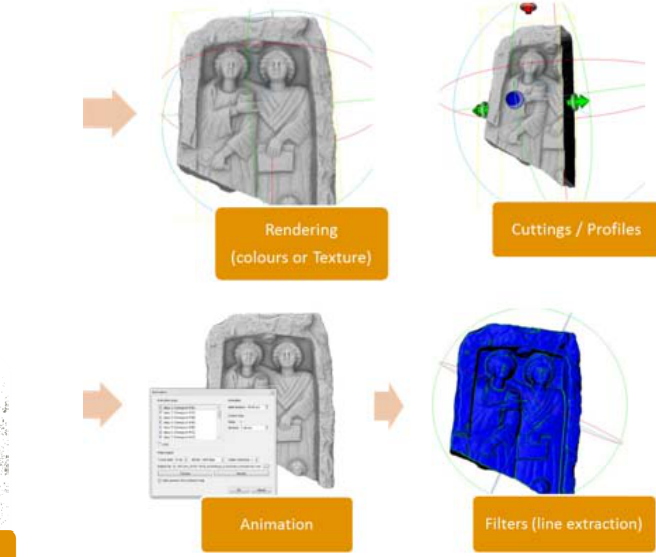
Figure 15: CloudCompare rendering, section, animation and line extration.